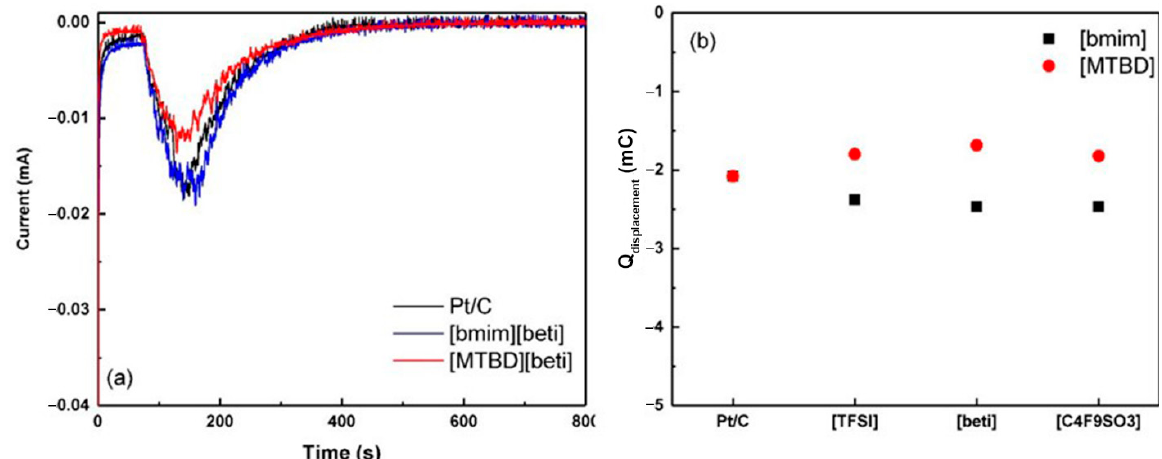
Figure 6. CO displacement characterization. ( a ) Current-time response after CO gas is introduced. ( b ) The summary of displacement charges of Pt/C and Pt/C-ILs. The potential was held constant at 0.5 V in air free 0.1 M HClO 4 .